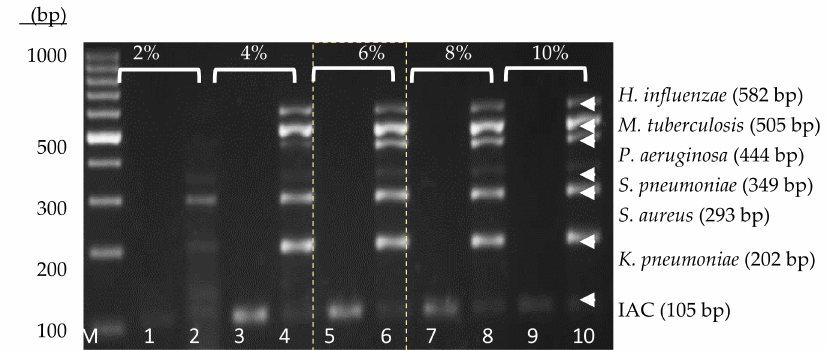
Figure 2. Agarose gel electrophoresis image for the optimization of trehalose enzyme stabilizer (2%, 4%, 6%, 8%, and 10%) along with the 100 bp DNA ladder. Lane 1 to Lane 10: the respective IACs and PACs at different concentrations of trehalose, ranging from 2% to 10%. The use of 6% trehalose was selected for this heptaplex PCR assay.